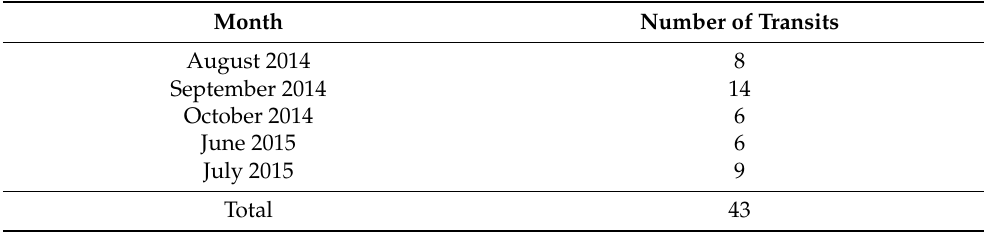
Table A5. Svetac–Biševo passage—number of cruise ships’ transits in selected high-risk navigational and environmental locations (passages).